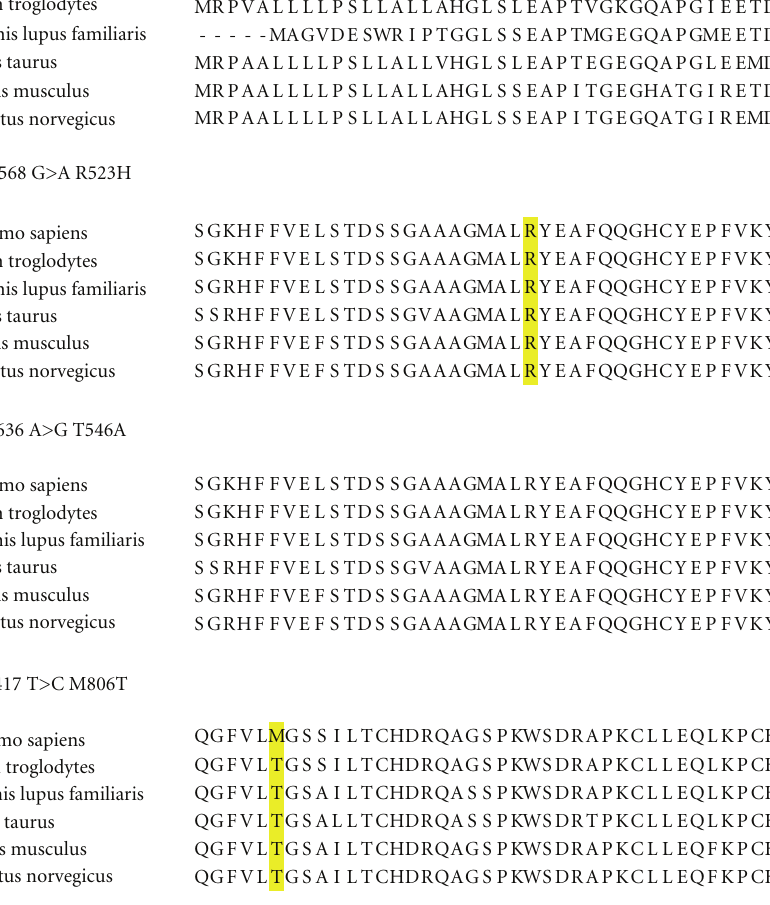
Figure 1: Evolutionary conservation of amino acid positions across vertebrates at sites of rare and common nonsynonymous amino acid substitutions within the SEZ6